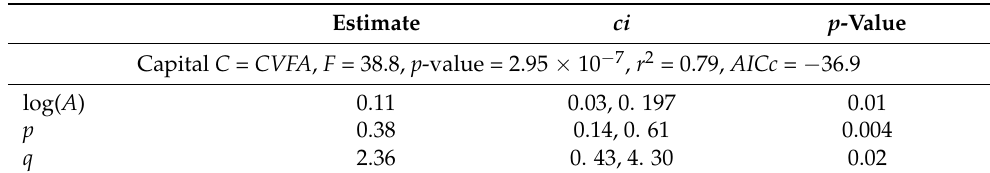
Table 3. Estimates of Cobb-Douglas PF parameters (1), F-statistics ( F ), adjusted coefficient of determination ( r 2 ), Akaike information criterion value for small samples ( AICc ), 95% confidence intervals ( ci ), p-values ( p -value), calculated on the basis of data for 2000–2020 using the utilization-adjusted value of fixed assets (CVFA) as capital.